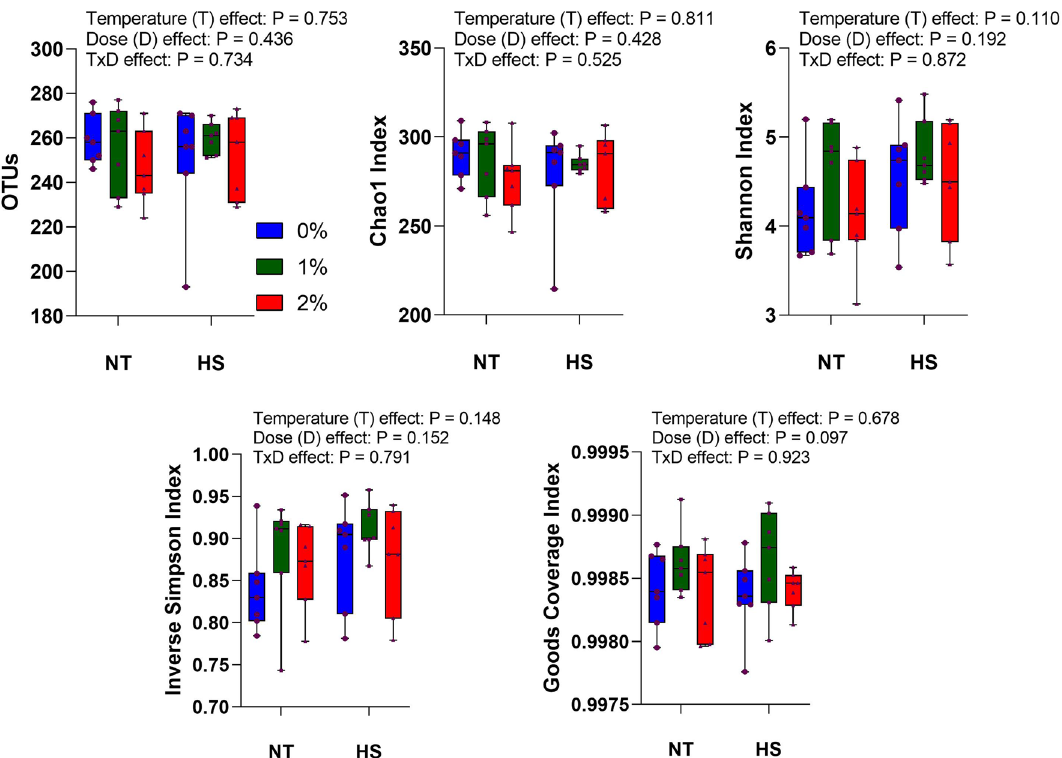
Figure 2. Effect of dietary steam-exploded pine particle supplementation on the community richness and alpha-diversity of cecum microflora of broilers reared under normal or cyclic heat stress conditions. Dietary treatments were 0, 1, and 2% SPP in diets respectively. The temperature of the rooms was maintained at either thermoneutral (NT; 21 °C) or cyclic heat stress (CHS; 31 °C; 6 h daily) for seven